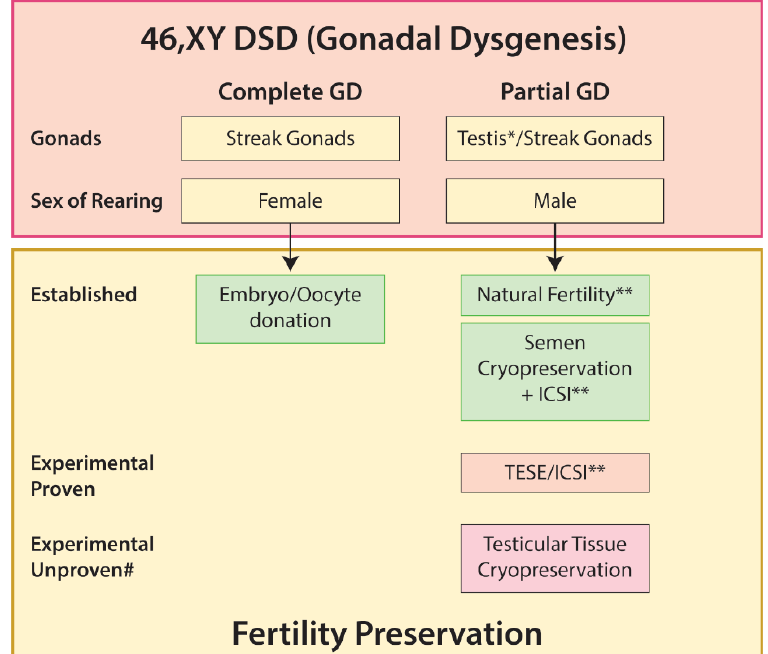
Figure 5. Options for fertility preservation in 46,XY DSD with gonadal dysgenesis. GD—gonadal dysgenesis. * Often dysgenetic. ** May be possible for milder phenotypes. # Potential for gonadal